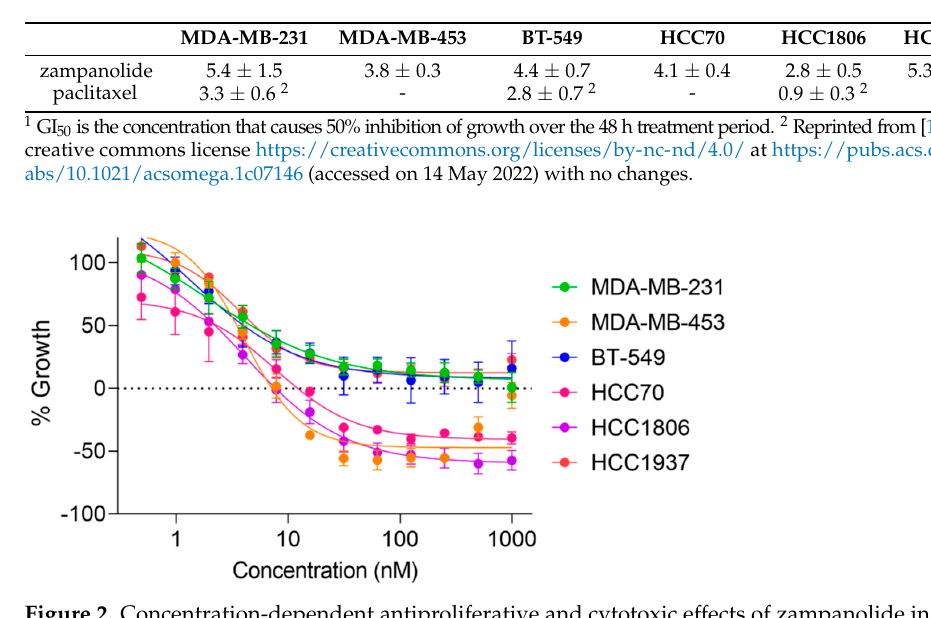
Table 1. GI 50 1 values (nM) calculated from zampanolide dose–response curves for each TNBC cell line. N = 3 ± SEM.